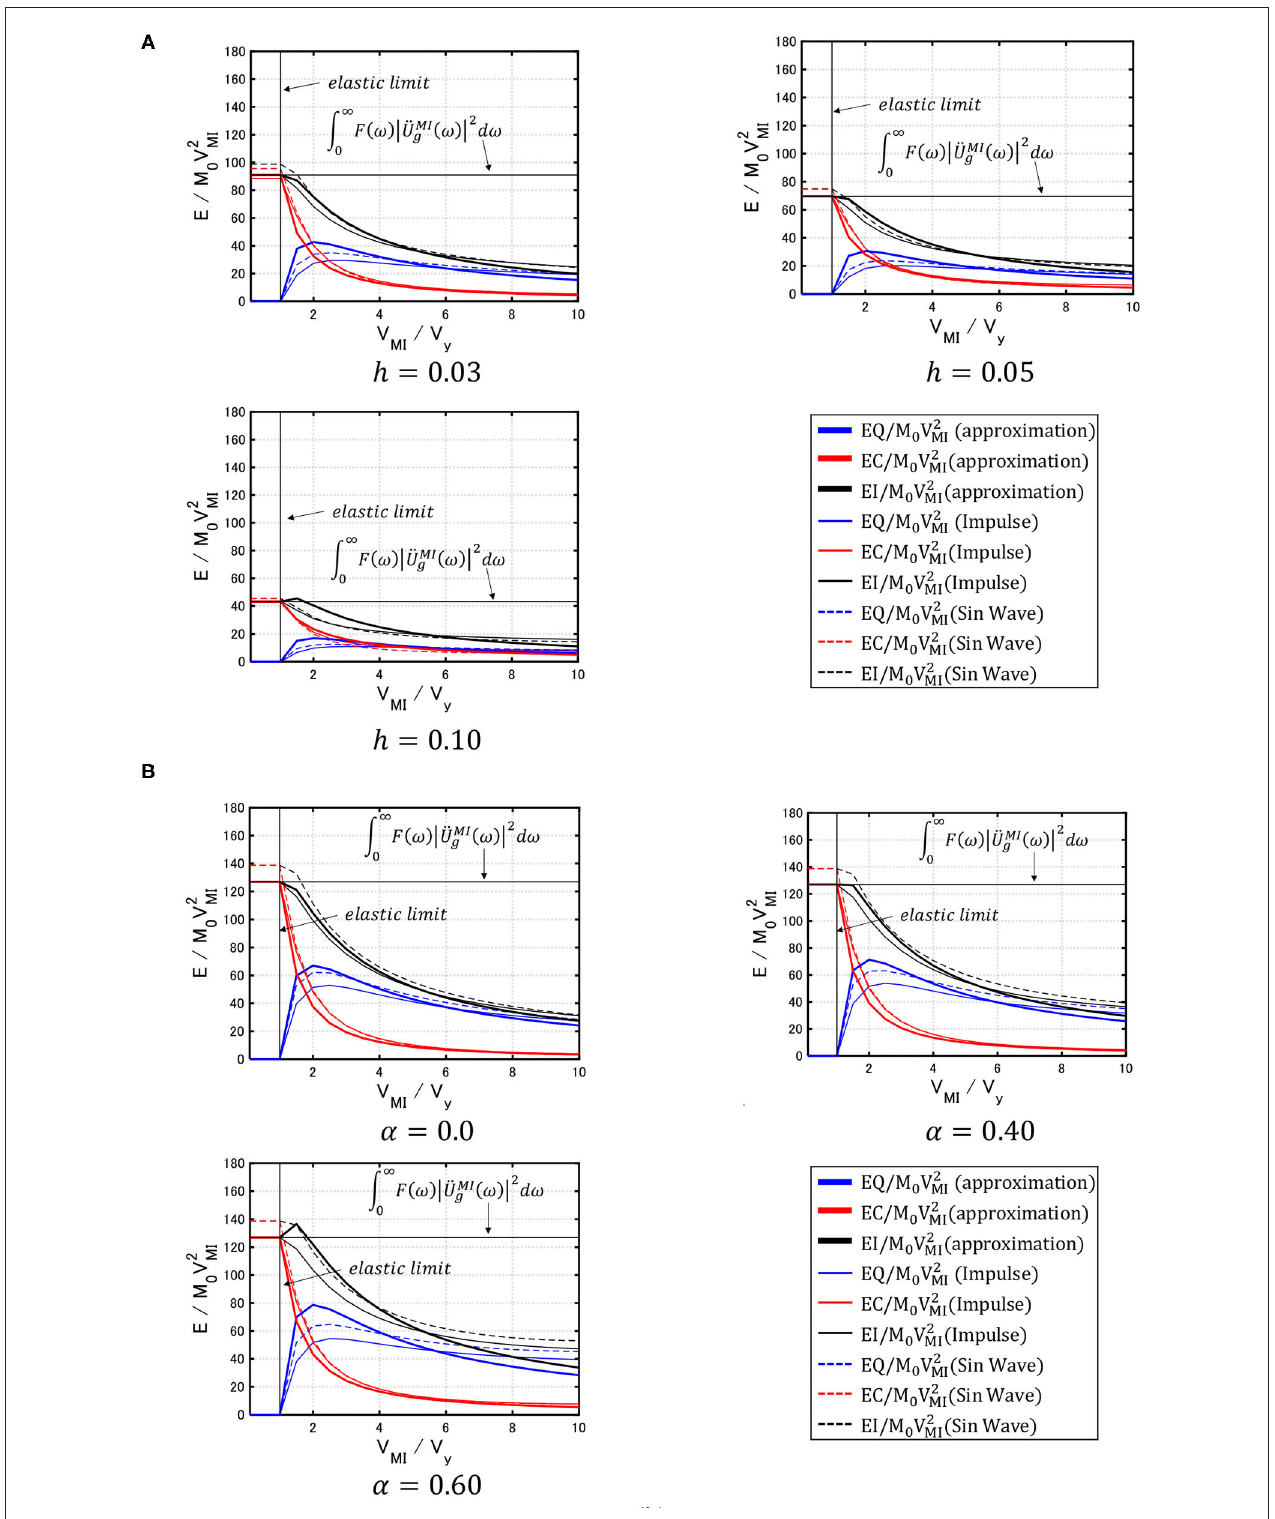
FIGURE 15 | Influence of structural model parameters on energy response (Model 3). (A) Effect of damping ratio. (B) Effect of post-yield stiffness ratio.